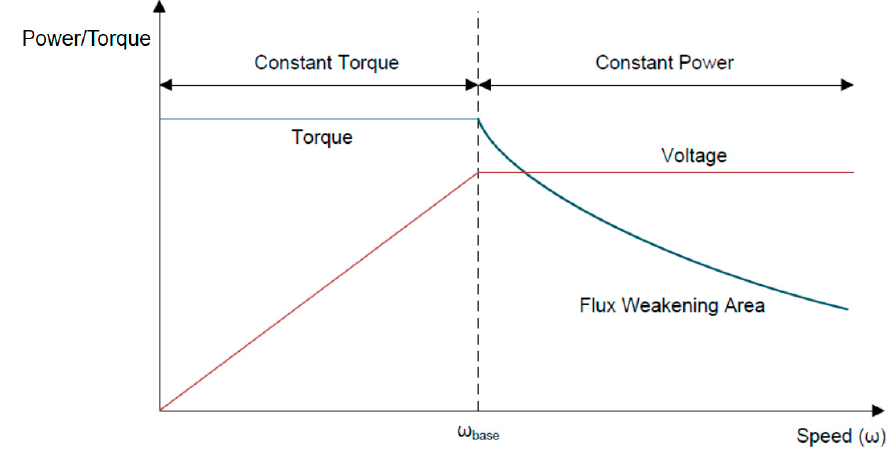
Figure 4. Typical torque rotational-speed characteristics of the IPMSM.